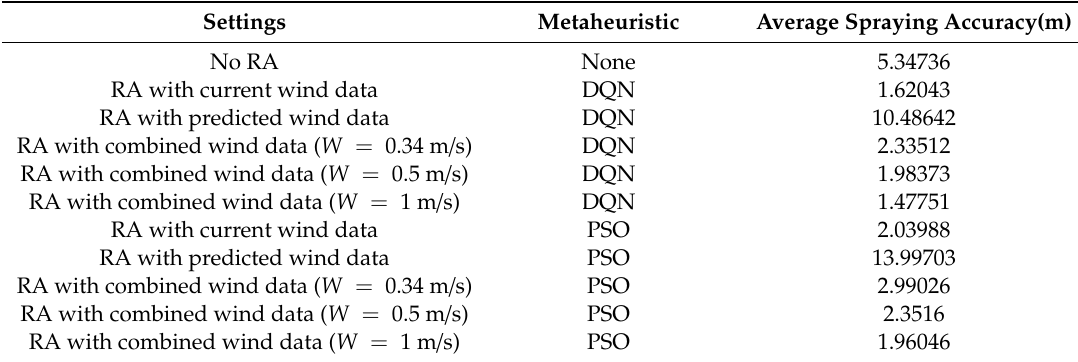
Table 5. Average spraying accuracy under di ff erent wind data.